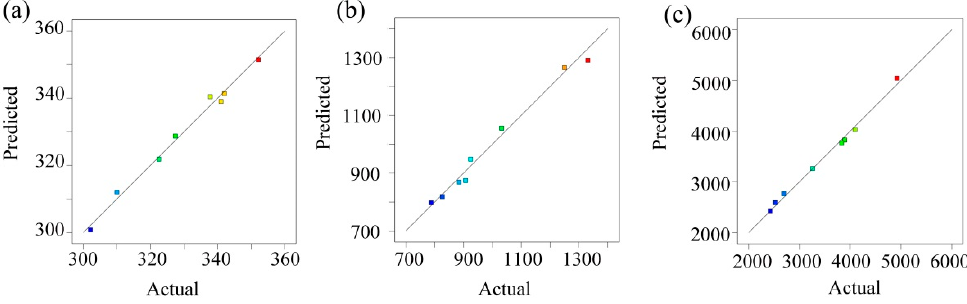
Figure 6. Correlation graphs of experimental and predicted values: ( a ) F x , ( b ) F y , and ( c ) F z .